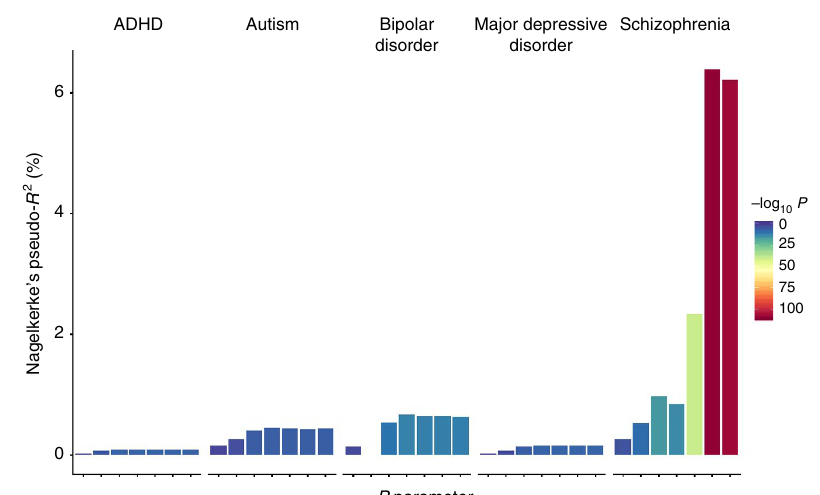
Figure 1 | Polygenic risk scores for psychiatric disorders predict their corresponding disorder in the general population of Iceland. The x axis shows the seven P -value parameters (0.001, 0.003, 0.01, 0.03, 0.1, 0.3 and 1.0) used to weight SNPs from the discovery GWAS plotted left to right. The y axis indicates the Nagelkerke’s pseudo- R 2 measure of variance